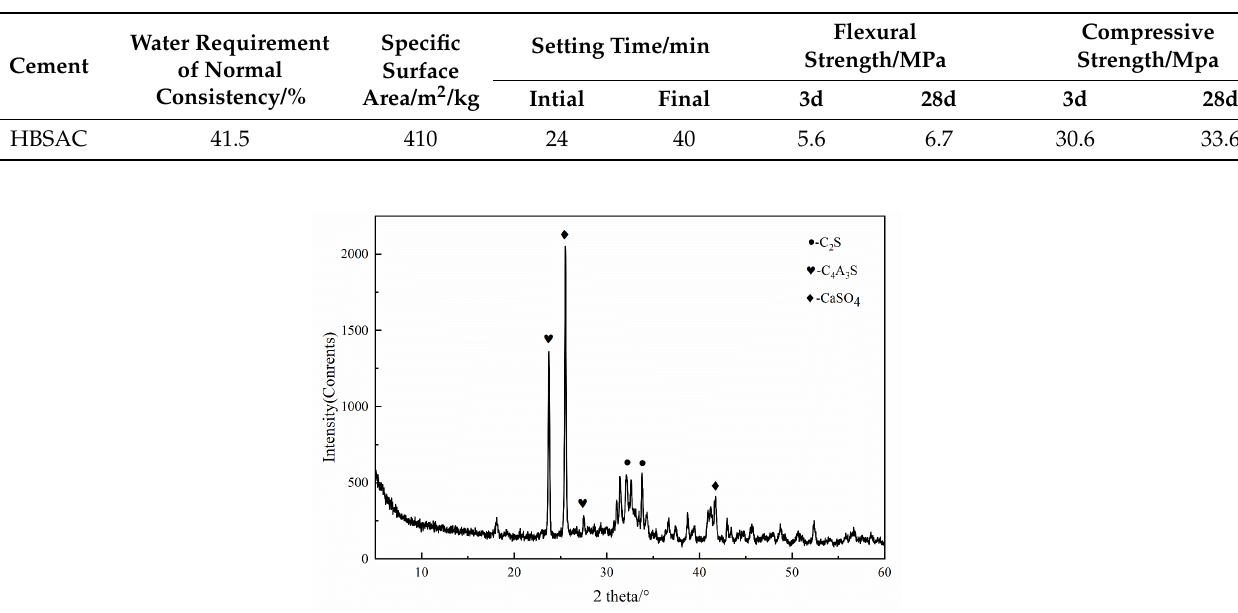
Table 2. Physical and mechanical properties of HBSAC.